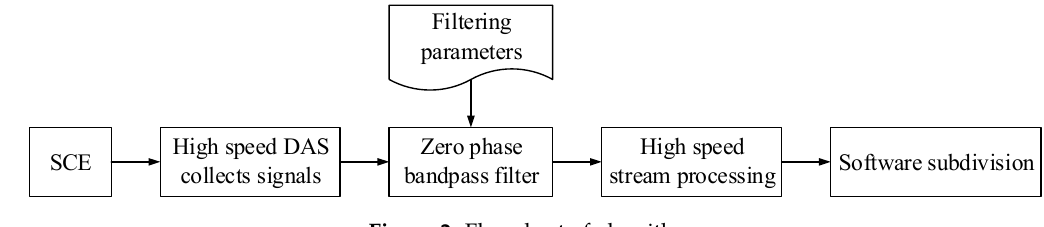
Figure 2. Flowchart of algorithm.